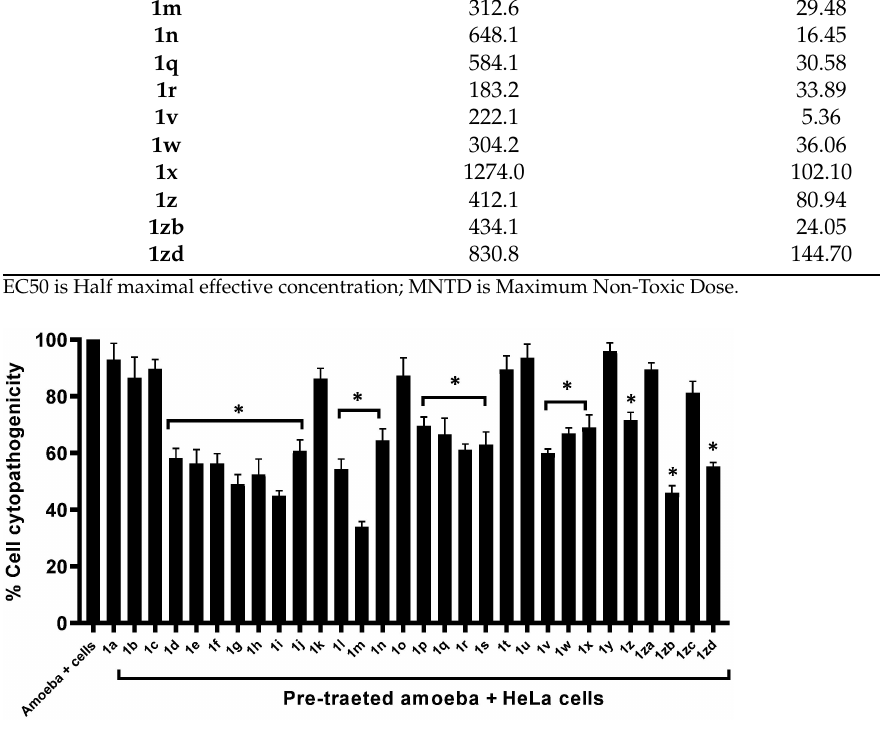
Figure 5. Pre-treatment of A. castellanii with compounds and their analogues remarkably decreased amoeba-mediated host cell death. Data is presented as mean ± standard error. p values were calculated using a two-sample t -test with a two-tailed distribution and (*) denotes that p ≤